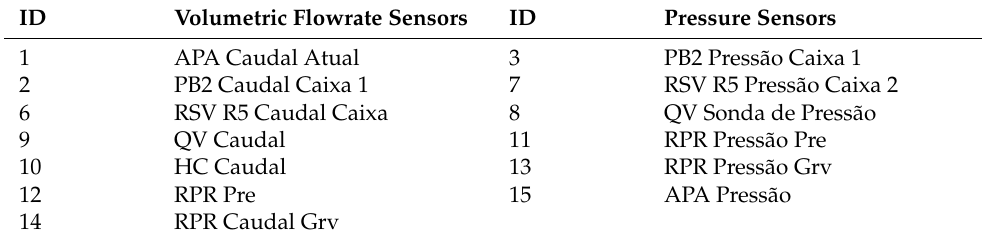
Table 3. Correspondence between the sensor location (Figure 5) and descriptors.